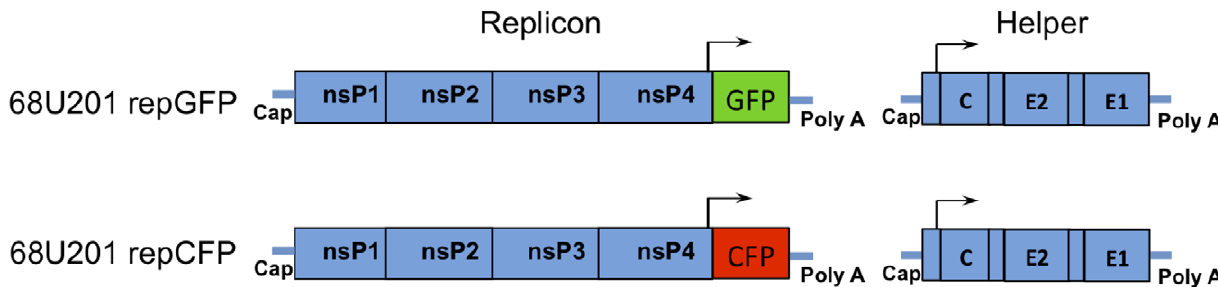
Figure 2. Schematic diagram of the replicons. (A) 68UGFP and (B) 68UCFP.